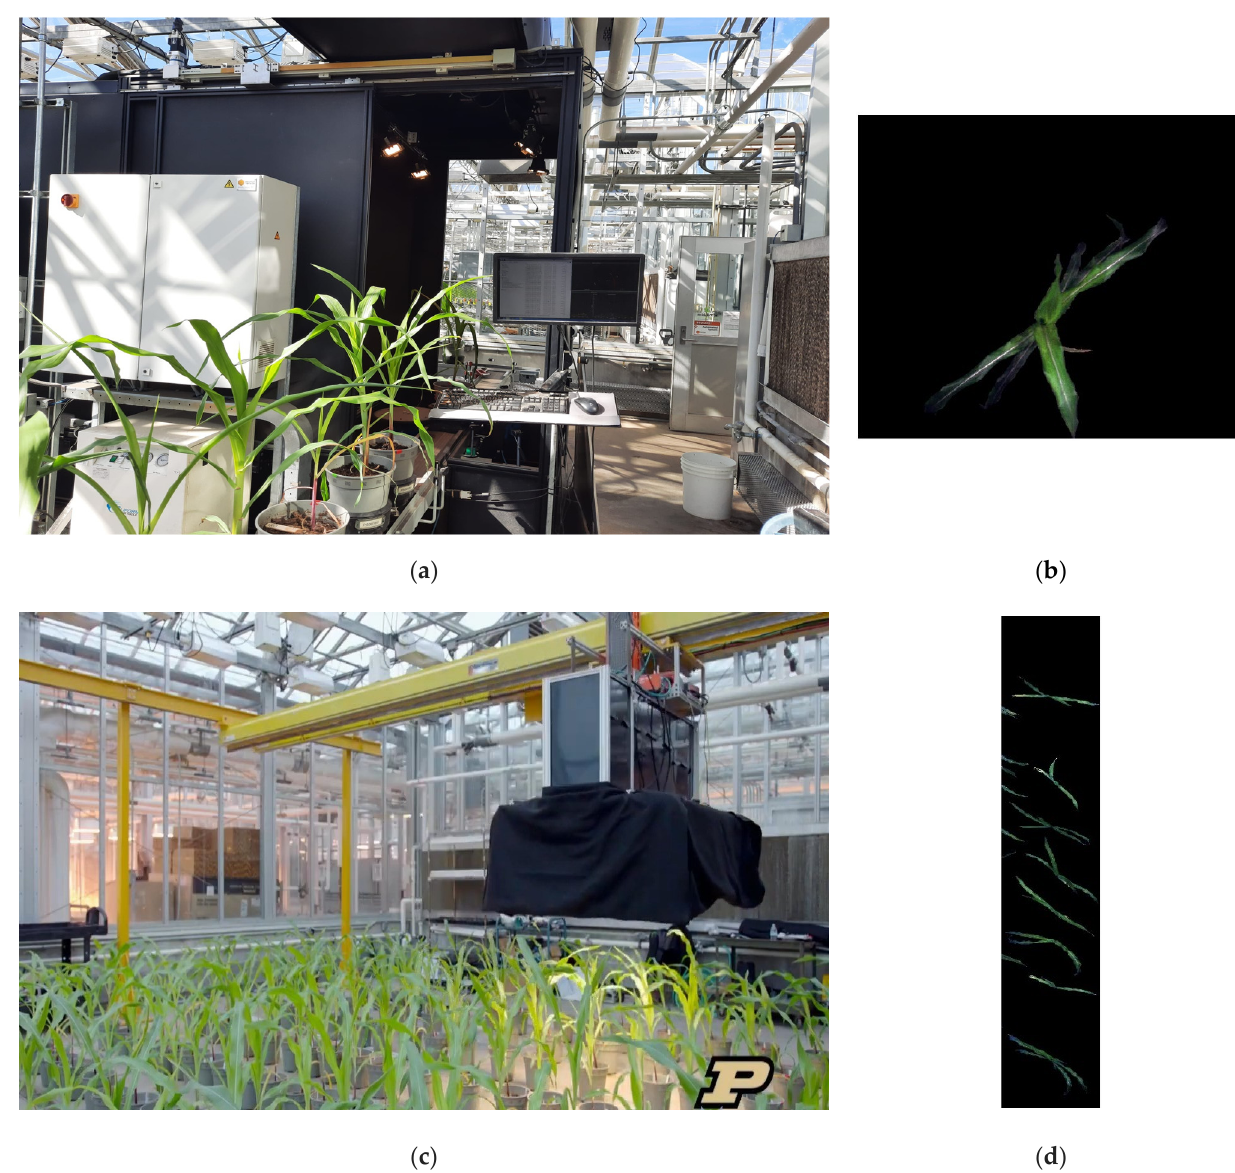
Figure 1. Two HTPP facilities used for this study: ( a ) a hyperspectral imaging tower, ( b ) masked RGB image of a plant, ( c ) gantry imaging facility, and ( d ) masked RGB image of multiple plants.